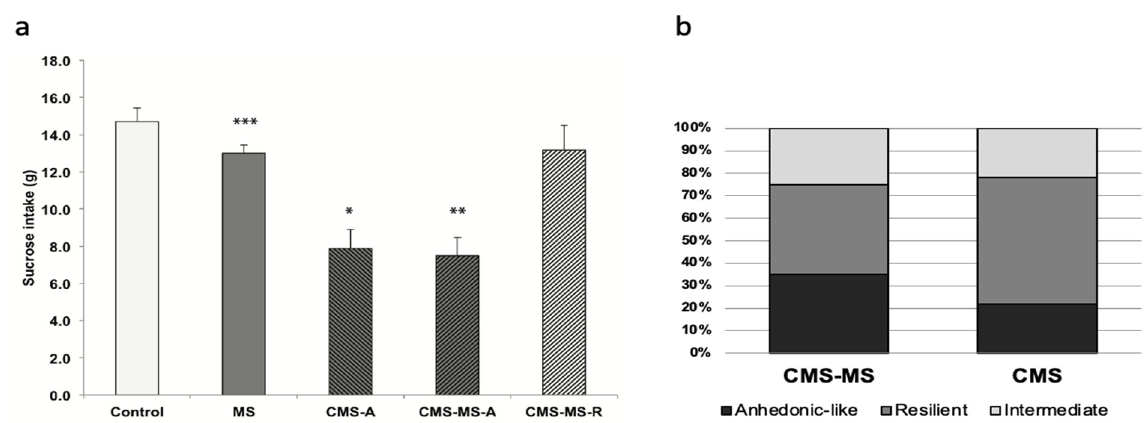
Figure 1. ( a ) Sucrose intake of rats in all the experimental groups. Control: unchallenged ( n = 10), MS: n = 10, CMS-A: animals exposed to chronic mild stress, exhibiting anhedonia ( n = 6), CMS-MS-A: n = 8, CMS-MS-R: n = 8. Data are shown as mean group sucrose intake +/ − SEM, comparing each group with the control group * = p < 0.05, ** = p < 0.02, *** = p < 0.001; ( b ) Increased stress susceptibility of rats shown as percentage of animals defined as anhedonic-like, resilient, or intermediate in the CMS or CMS-MS group after seven weeks of